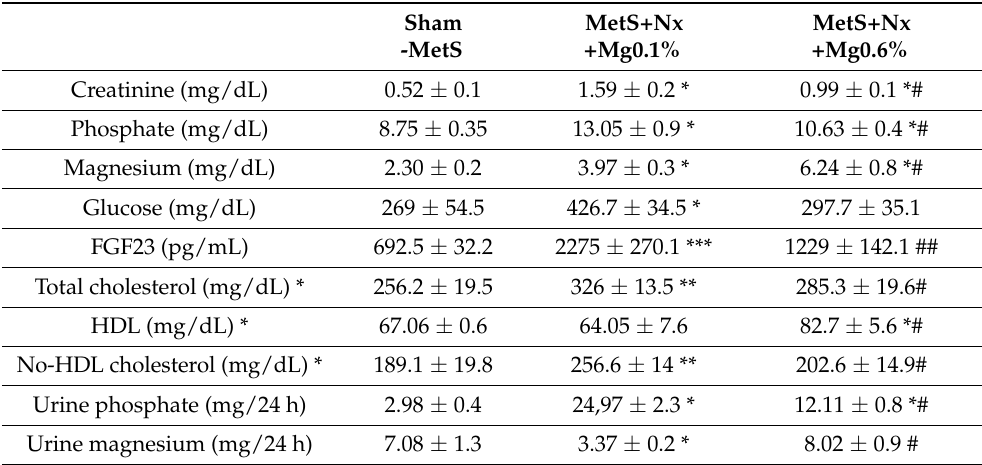
Table 1. Serum and urine biochemical parameters.